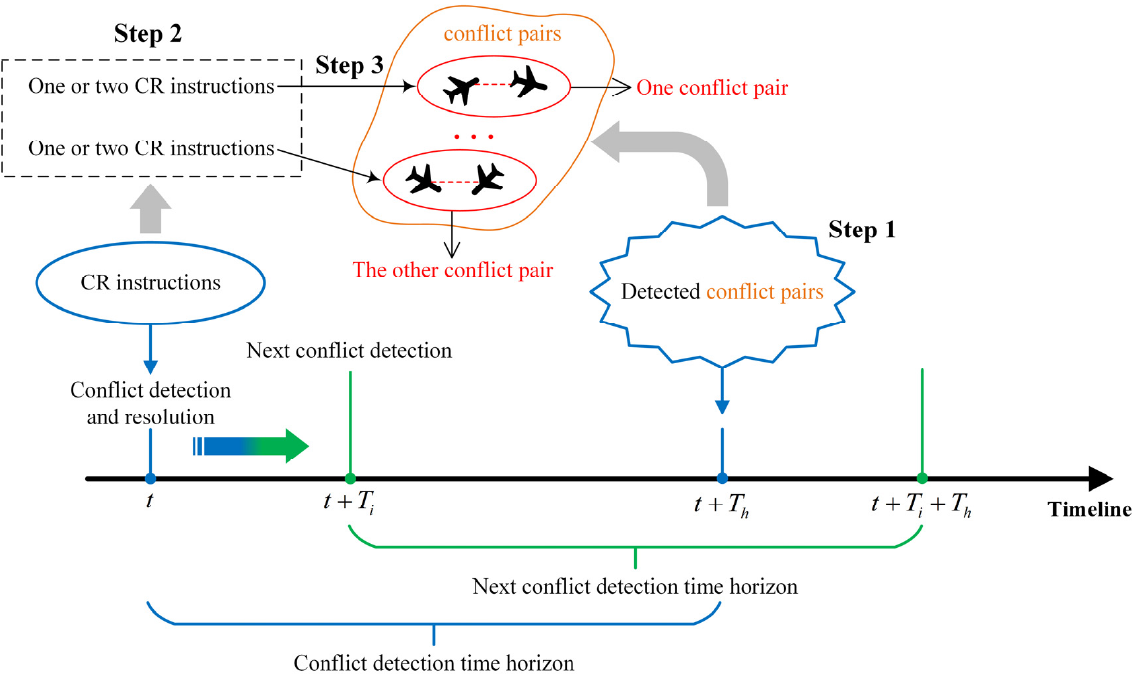
Figure 2. CD&R mechanism in continuous time.